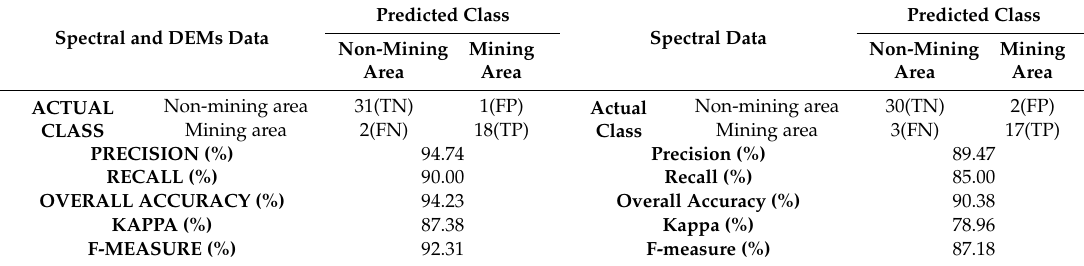
Figure 4. Superimposed map of real mining areas and identified geological areas with omission and commission areas. ( a – c ) are located in the southwest of the study area, ( d , e ) lie in the northeastern part, and ( f – i ) are situated in the southeastern part. Table 3. Precision, recall, overall accuracy, the kappa coe ffi cient, and the F-measure of the confusion matrix based on test data and each superimposed mask of the predicted mines by di ff erent combination methods to show the e ff ectiveness. (TP: true positive, TN: true negative, FP: false positive, and FN: false